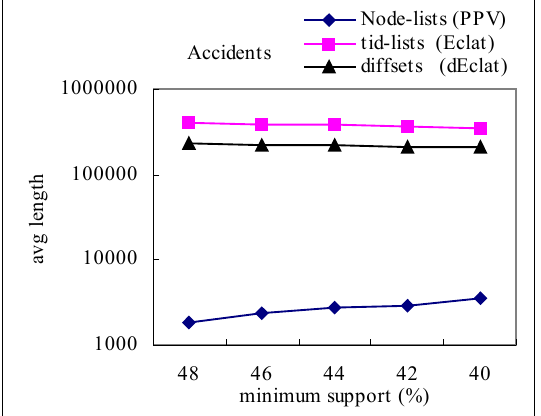
Fig. 6. Comparative Performance on T40I10D100K